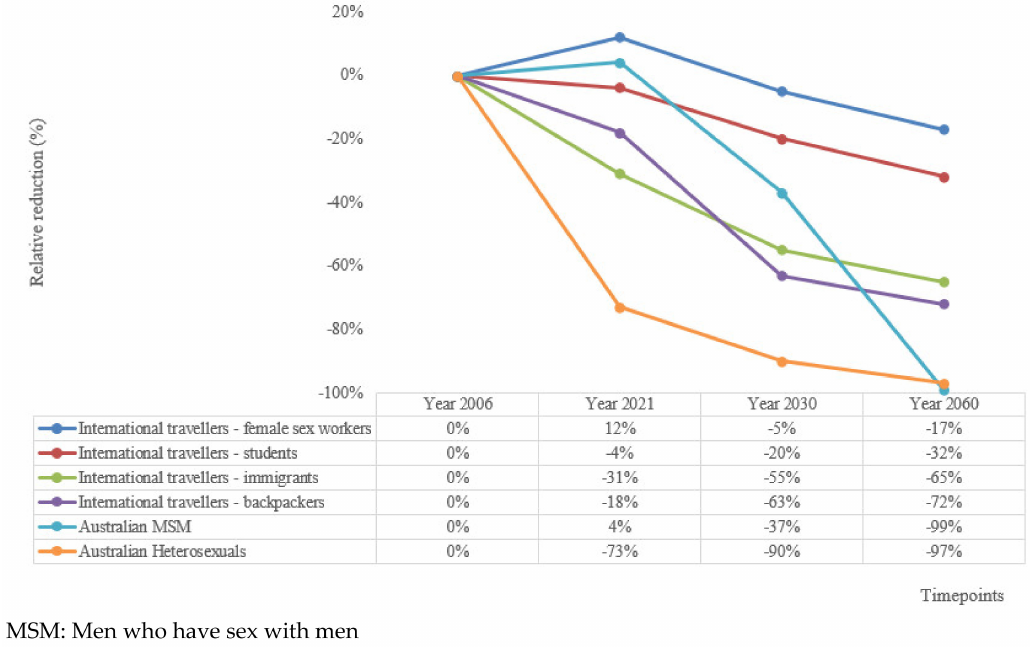
Figure 2. Revised estimates of relative reduction in new cases of genital warts in Australia, in all populations considered, after adjusting for the ongoing transmission due to importation of genital warts, by time period.